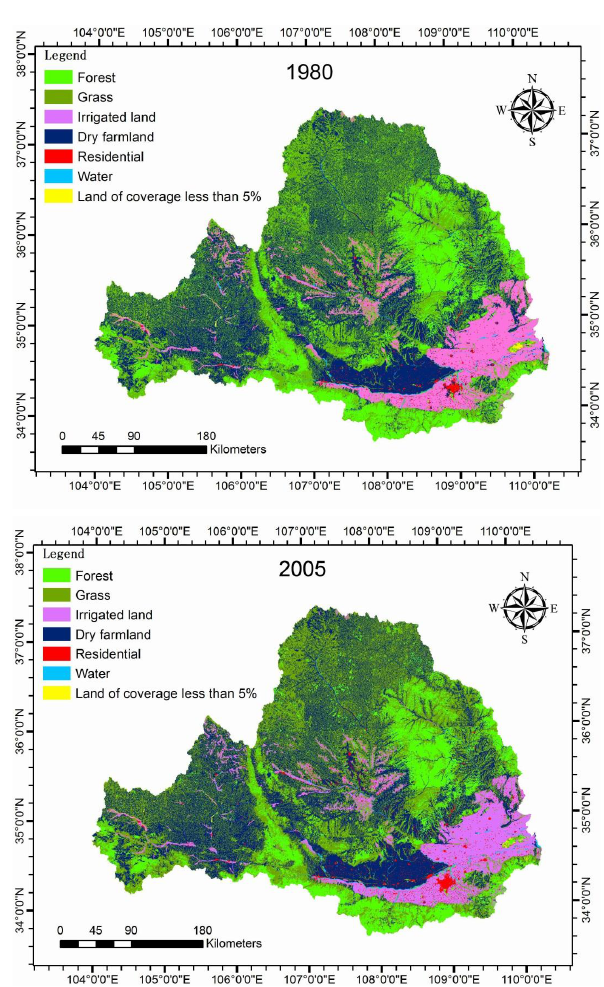
Fig. 2. Land use and cover of Wei River basin in 1980 and 2005 (the data is provided by the National Science and Technology In- frastructure Center, Data-Sharing Network of China Earth System Science,